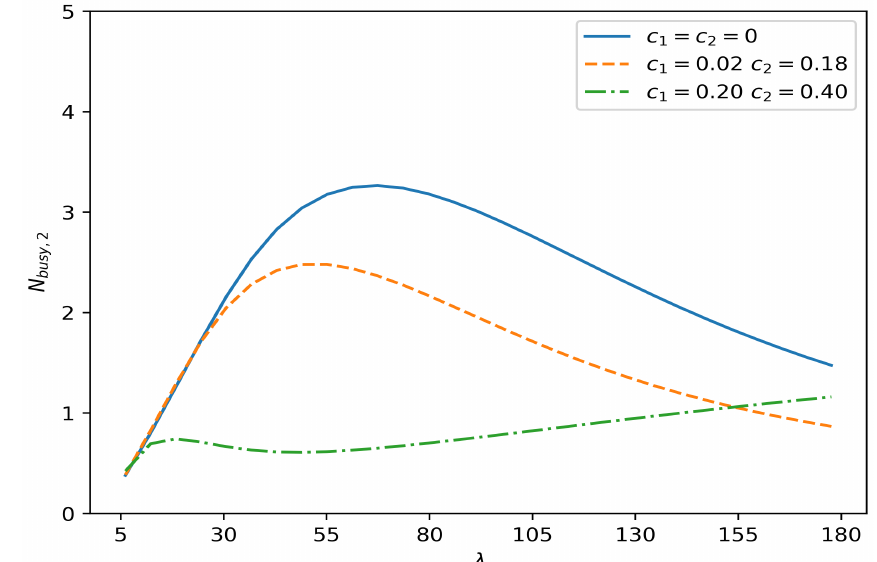
Figure 5. Dependence of the mean number N busy ,2 of servers providing service to non-priority customers on the input rate λ for the MMAP s with different coefficients of